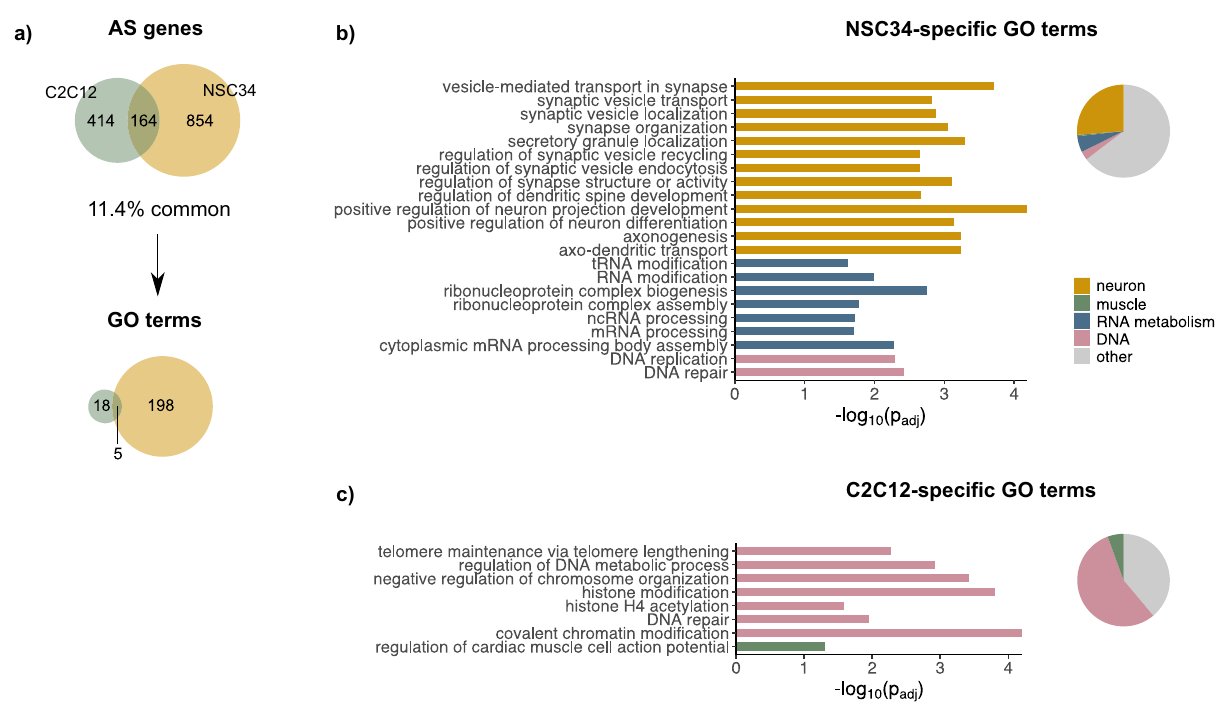
Fig. 4 TDP-43-regulated transcripts are enriched in neuronal functions and DNA-related processes. a Venn diagrams show the number of alternatively spliced transcripts (as detected by rMATS at FDR < 0.01 (Fig. 3a, Supplementary Data 3)) in C2C12 and NSC34 cells together with GO terms (category: biological process, p adj < 0.05) enriched in AS genes detected in each cell line. b GO terms uniquely enriched in NSC34 (198) imply on deregulation of neuronal processes, mRNA metabolism and DNA biology in NSC34 cells (representative GO terms are shown on the plot). c GO terms uniquely enriched in C2C12 (18) suggest involvement of TDP-43-regulated AS genes in DNA-modifying processes (representative GO terms are shown on the